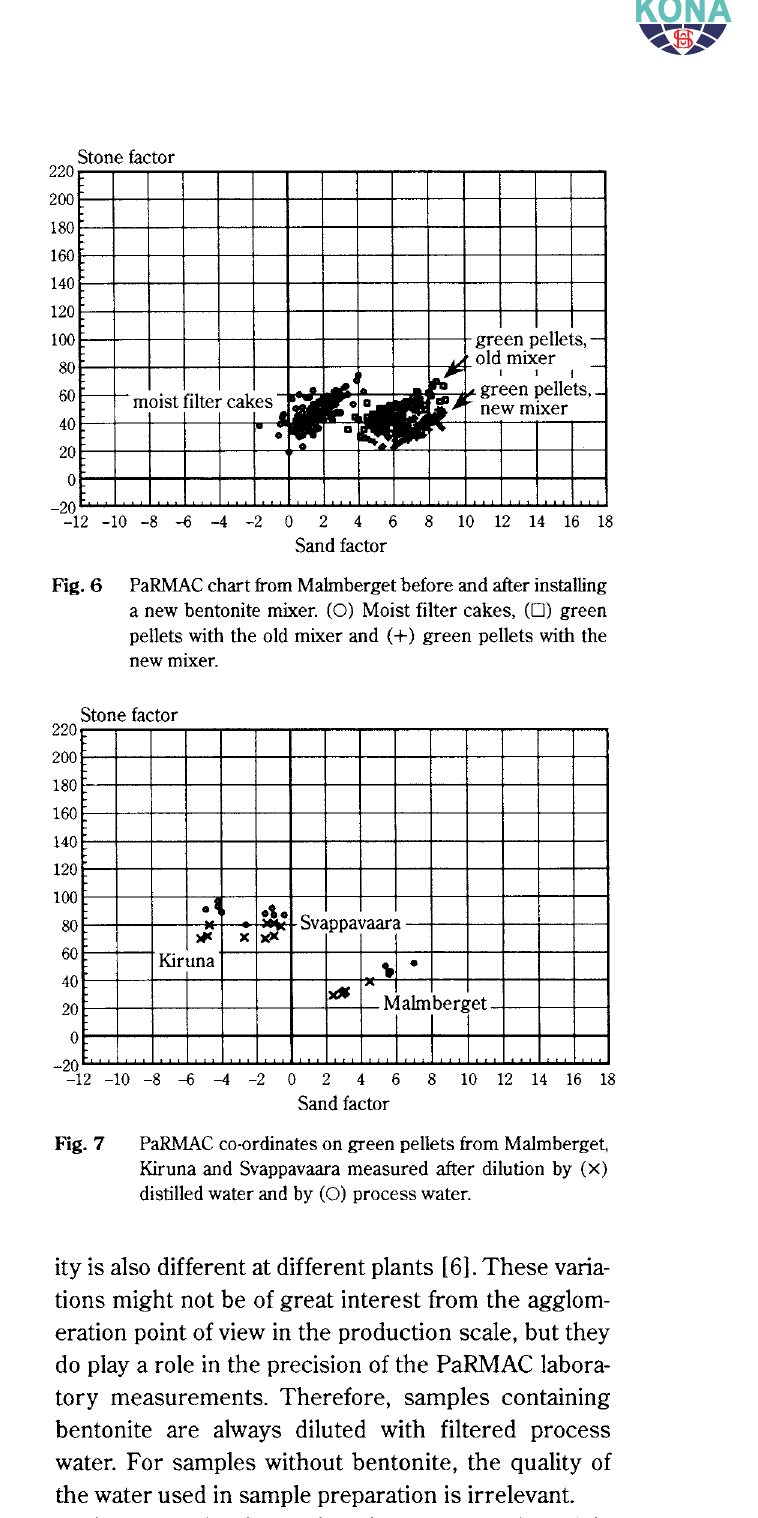
Fig. 7 PaRMAC co-ordinates on green pellets from Malmberget, Kiruna and Svappavaara measured after dilution by (X) distilled water and by (0) process